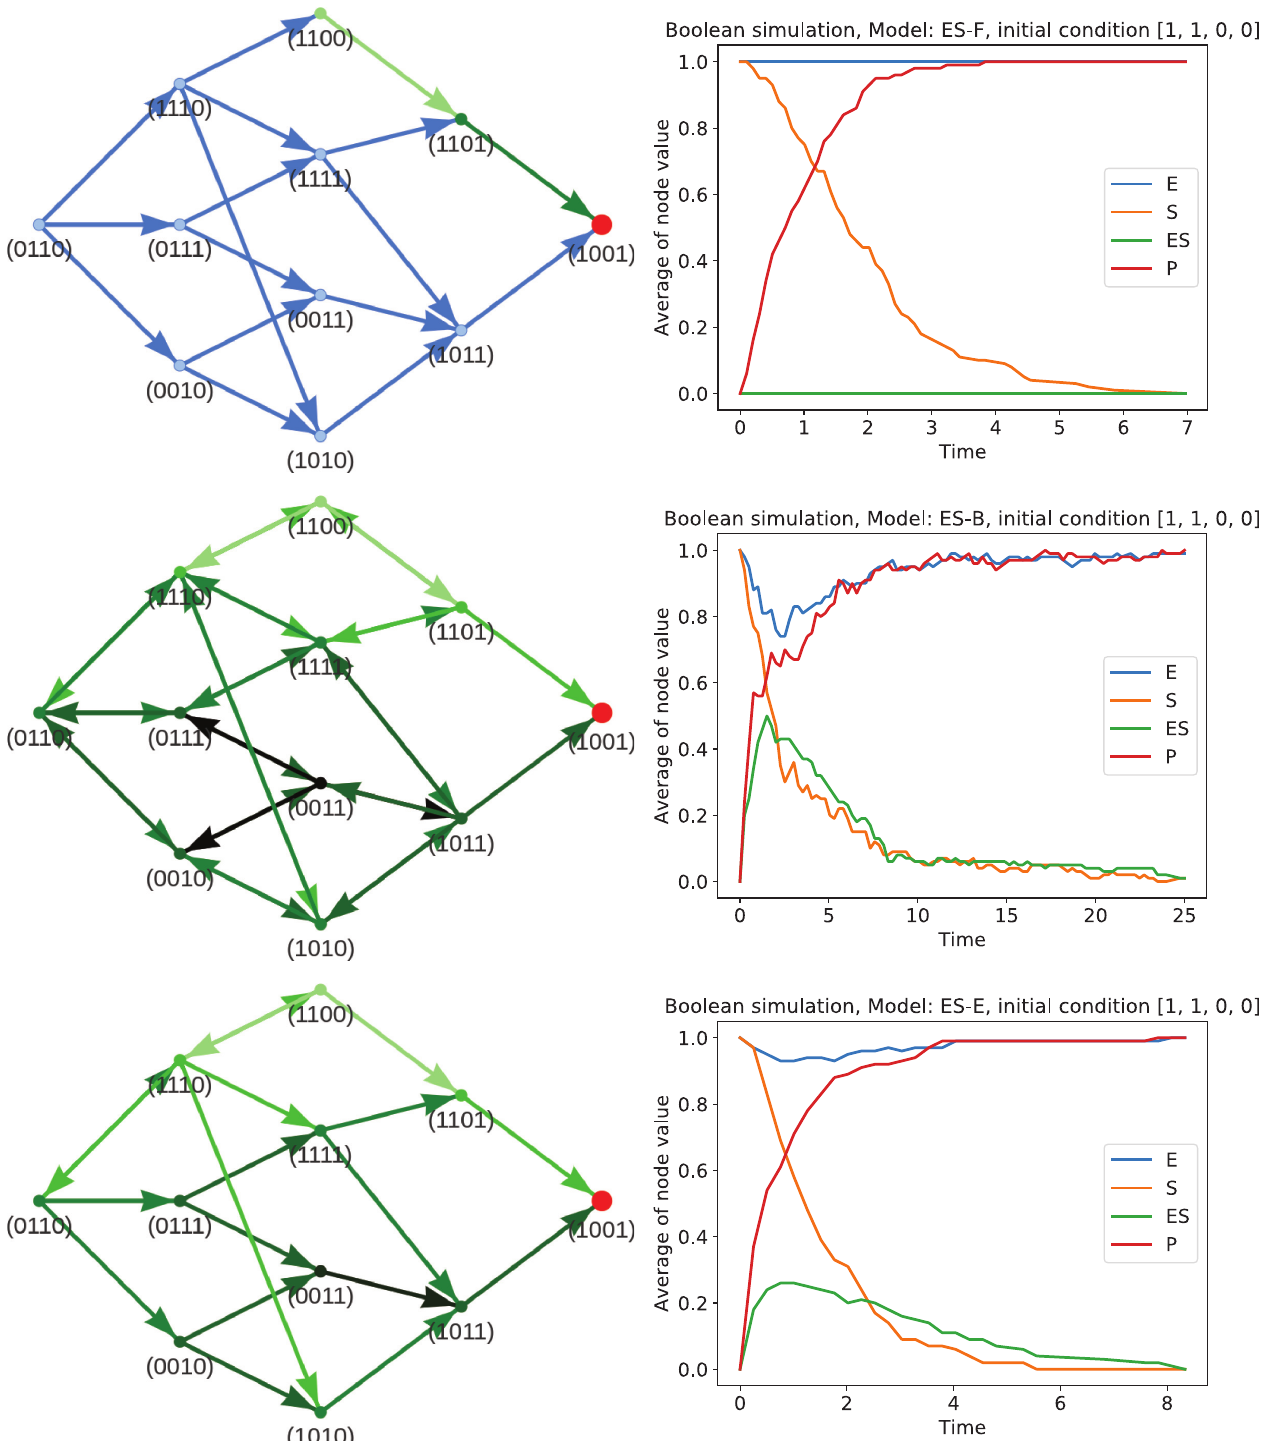
Fig 3. State transition graphs for the Boolean networks created by our proposed rules generator (left) for the enzyme-substrate mechanics and their resulting dynamics after 100 asynchronous updating simulations for the initial state ( E , S , ES , P ) = (1, 1, 0, 0) (right). The first row depicts the resulting network from the forward-only pathways network (ES-F), the second row the network including backward paths (ES-B), and the third row the network including expert knowledge (ES-E). For the network representation, the pathway for state (1, 1, 0, 0) to reach the steady state is highlighted in green. The darker the arrow, the more simulation steps are necessary to reach this particular transition. For the dynamics plots (right), the fraction of 100 simulations of the asynchronous updating scheme that are on/off is shown on the y -axis. The x -axis shows the number of simulation steps taken, representing the number of steps necessary for all 100 simulations to reach the steady